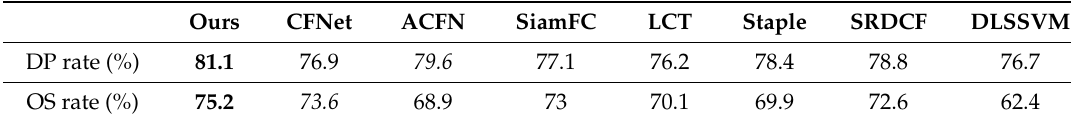
Table 2. The performance on OTB2015 dataset of eight